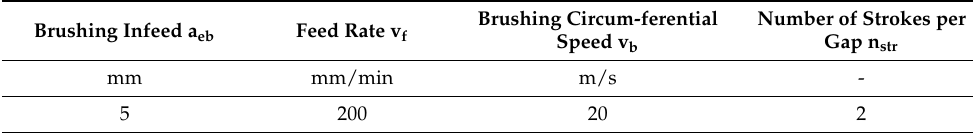
Table 4. Brushing process parameters.